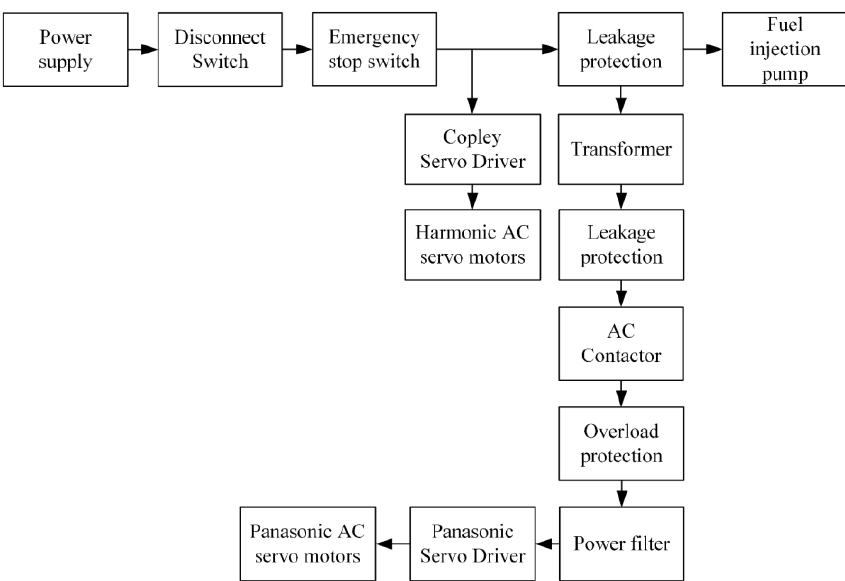
Figure 10. Schematic diagram of electrical connections.